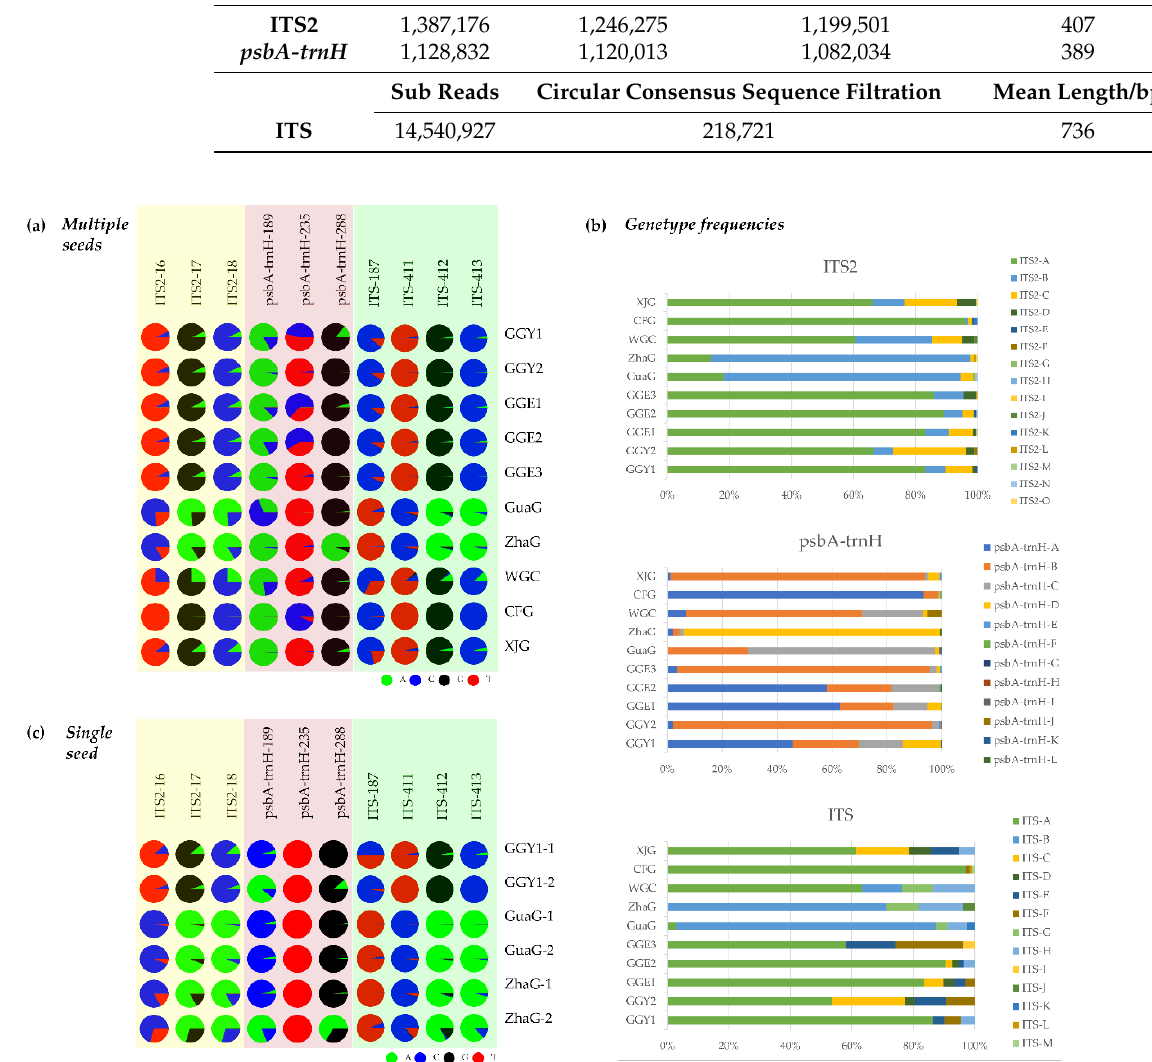
Figure 3. Percentage frequency of each base of genotype and mutation site. ( a , c ) The statistics of frequency percentage of each base of the variation site in multiple seeds and single seed samples, respectively. Yellow, pink, and cyan indicate molecular markers ITS2, psbA-trnH , and ITS. Each nucleotide is color-coded: A for adenine in green, T for thymine in red, C for cytosine in blue, and finally G for guanine in black. The matrix pie chart was plotted by http://www.bioinformatics.com.cn, accessed on 13 August 2021, an online platform for data analysis and visualization. ( b ) The frequencies of different genotypes in molecular markers ITS2, psbA-trnH , and ITS of multiple seeds, from top to bottom.